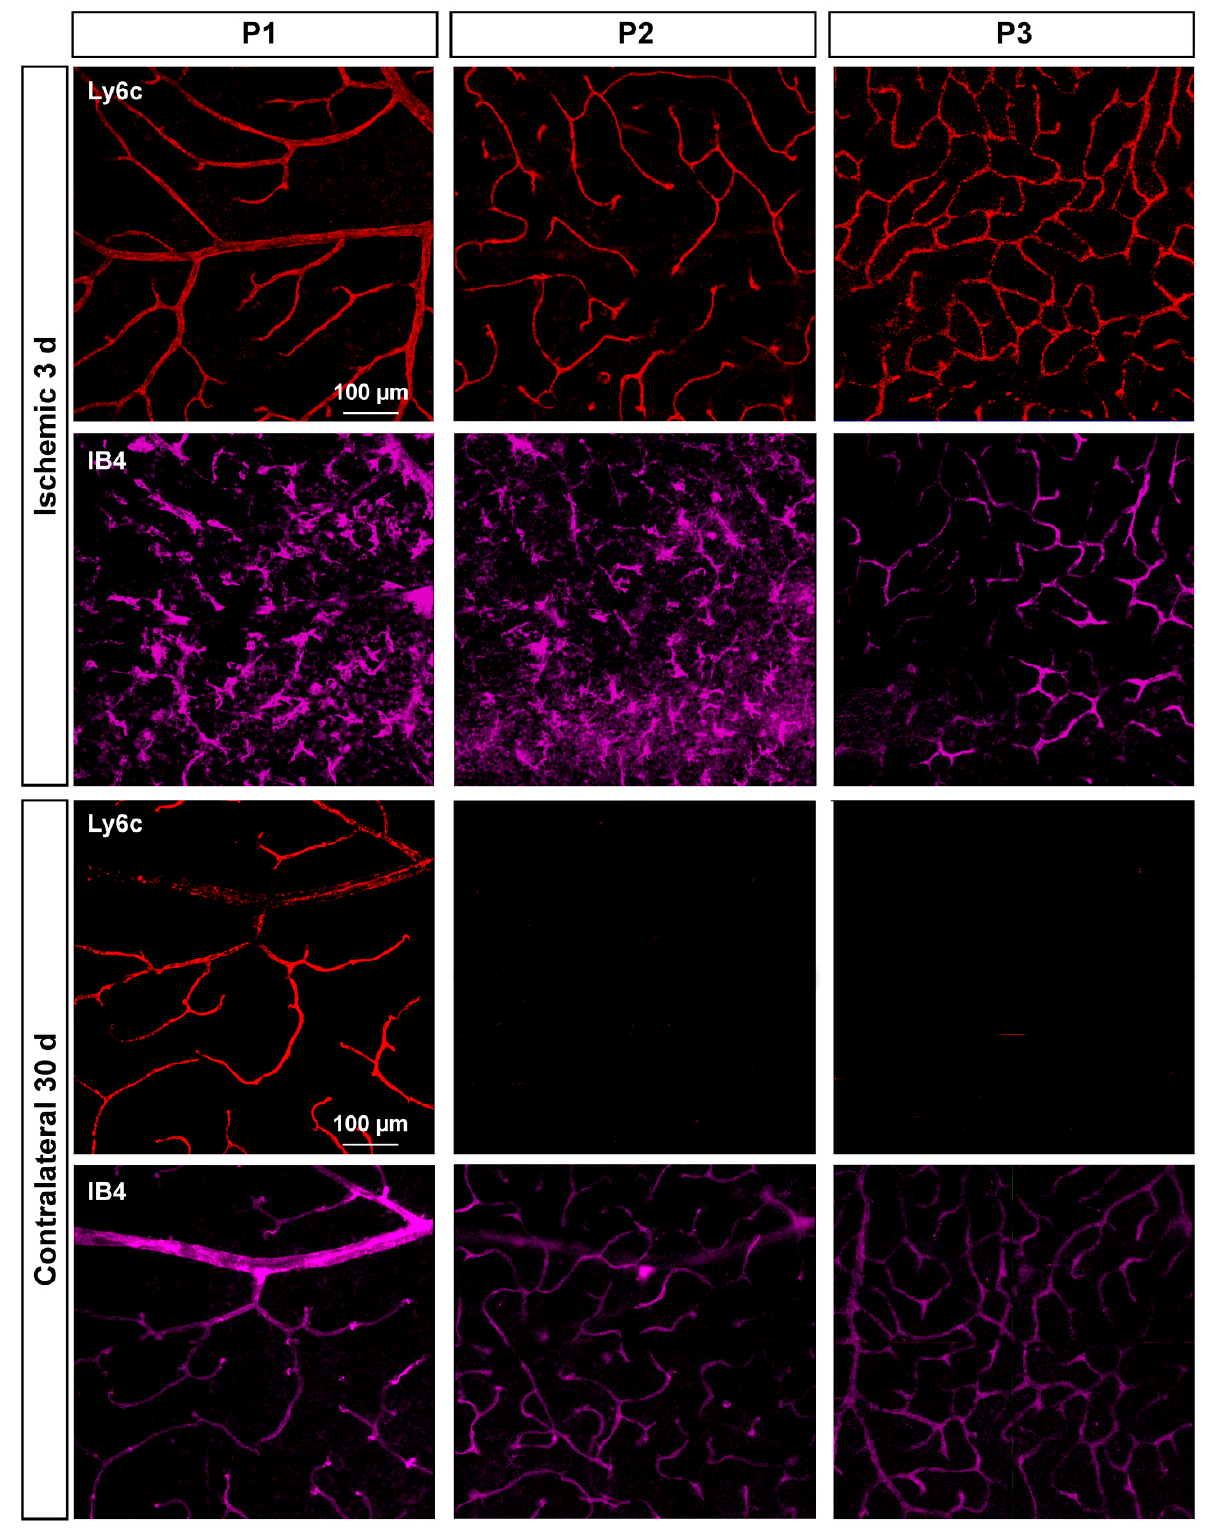
Figure 9. Microglial activation in the injured retinas and down-regulation of Ly6c in the contralateral ones. Confocal images showing Ly6c and IB4 staining in the three vascular plexuses of injured and contralateral retinas analyzed at 3 and 30 days after the induction of the ischemia, respectively.